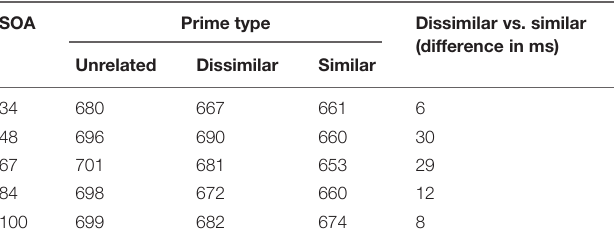
TABLE 2 | Raw values of mean decision latency for targets after (form similar) semantically similar, dissimilar, and unrelated primes at five stimulus onset asynchronies (SOAs).